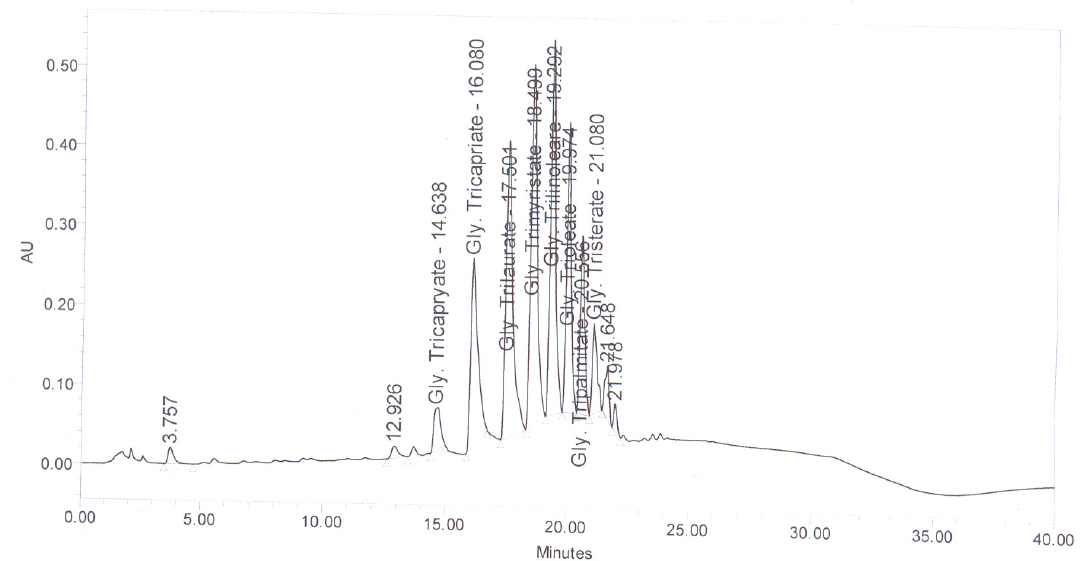
Figure 6. HPLC Chromatogram of coconut oil.